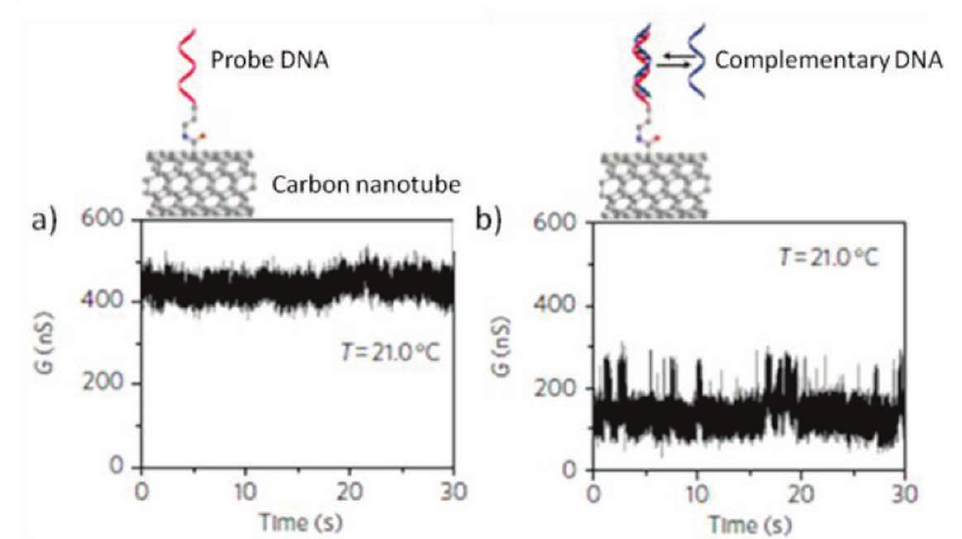
Figure 6. Conductance recordings of device over one 30s interval with DNA oligonucleotide probe NH exposure to the complementary DNA target. Reprinted with permission from [50]. Copyright 2011 Nature Publishing Group [50].